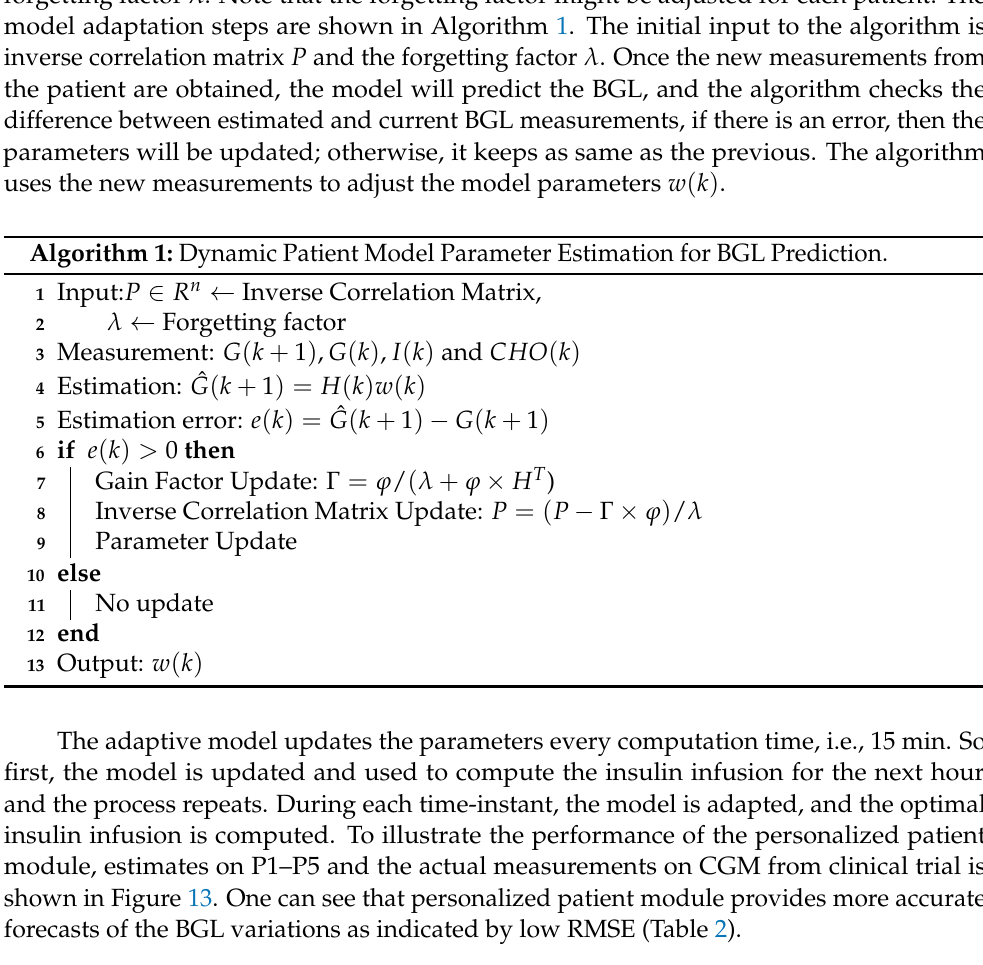
Table 2. Patient simulator Prediction